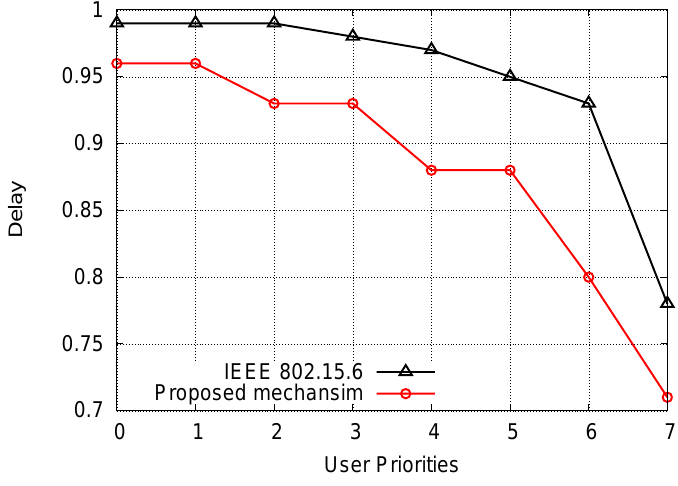
Figure 8. Delay comparison of IEEE 802.15.6 and proposed mechanism for different UP (Scenario